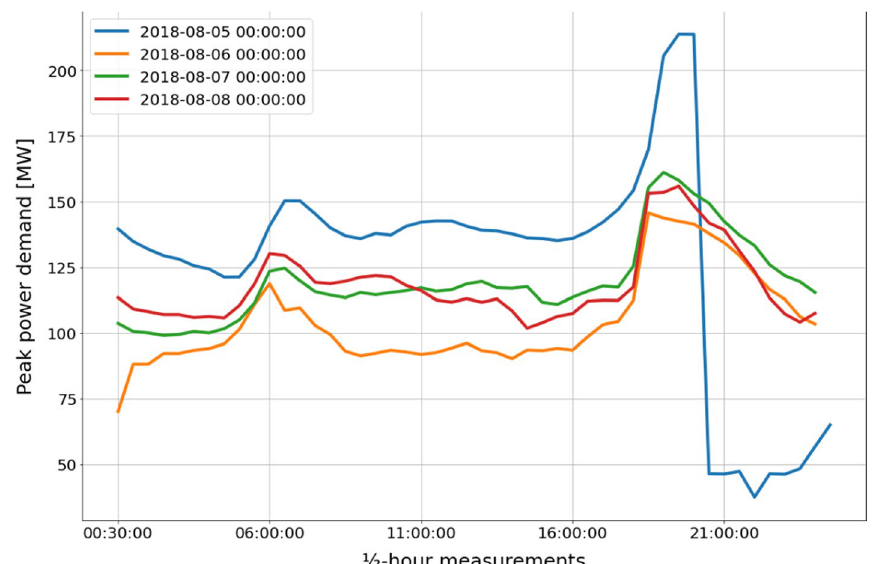
Fig. 28 The electricity load profiles for Lombok on 5–8 August 2018